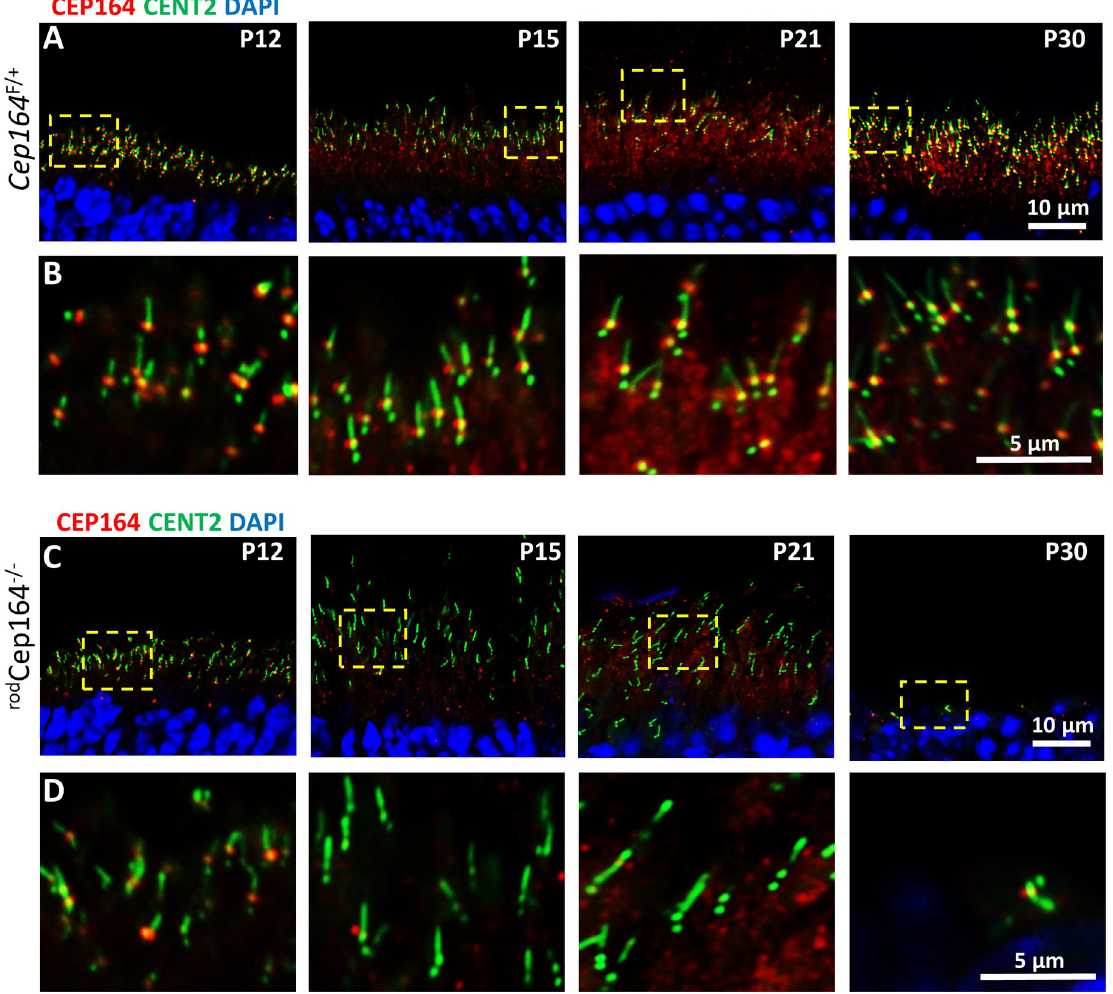
Fig 4. Cep164 rod knockout BB/CC stability. Row A, Cep164 +/F ; iCre75 ( rod Cep164 +/F ) retina cryosections on Egfp-Cetn2 + background probed with CEP164 antibody (red) at P12, P16, P21 and P30. Row B , enlargements as indicated by dashed squares in row A. Row C , rod Cep164 -/- cryosections probed with CEP164 antibody. Row D , enlargements as indicated by dashed squares in row C. Note CEP164 is attached to rod Cep164 -/- BB at P12, but lost at P15 and P21. BB and CC appear perfectly normal at P15 and P21 in the absence of CEP164. At P30, rods are degenerated. Scale bar, 10 μ m in rows A and C, 5 μ m in rows B and